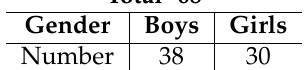
Table 1. Distribution of patients